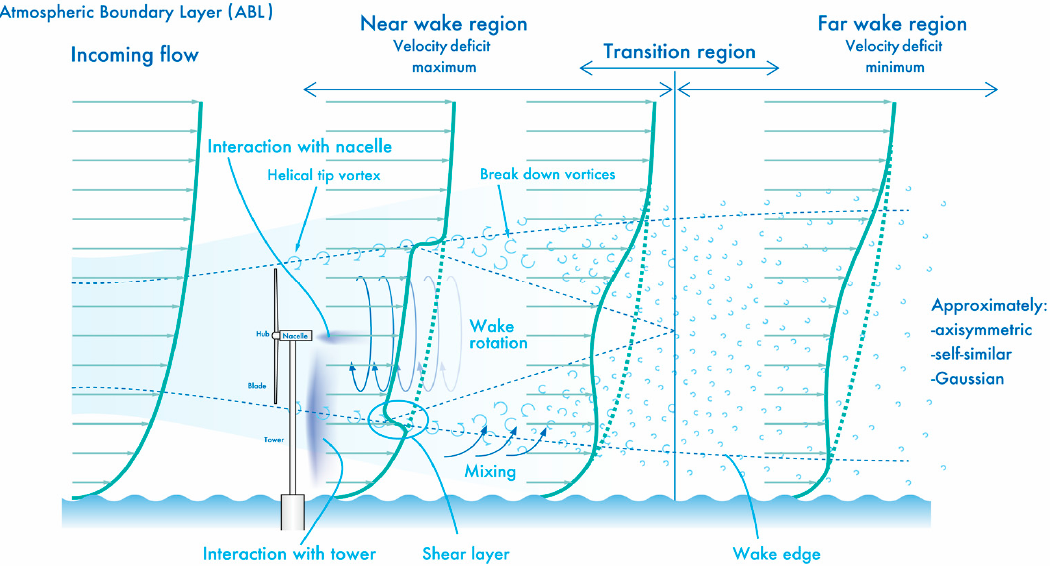
Figure 1. Schematic side view of wake structure behind wind-turbine.